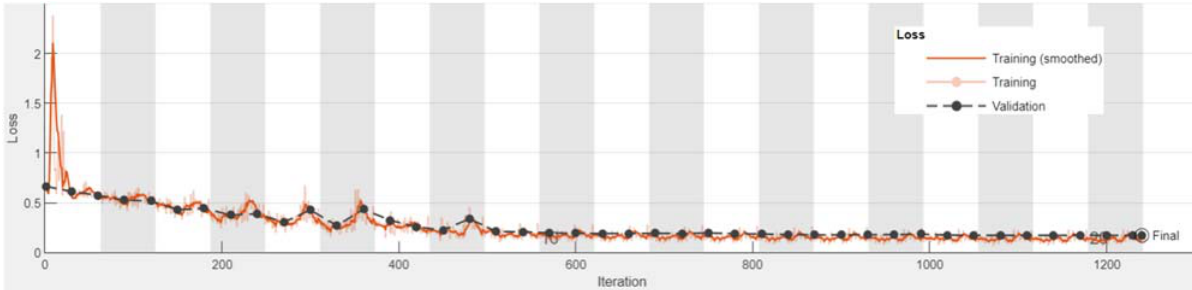
Fig. 12. Loss changes in CNN training process. Table 2 . Confusion matrix for validation data.